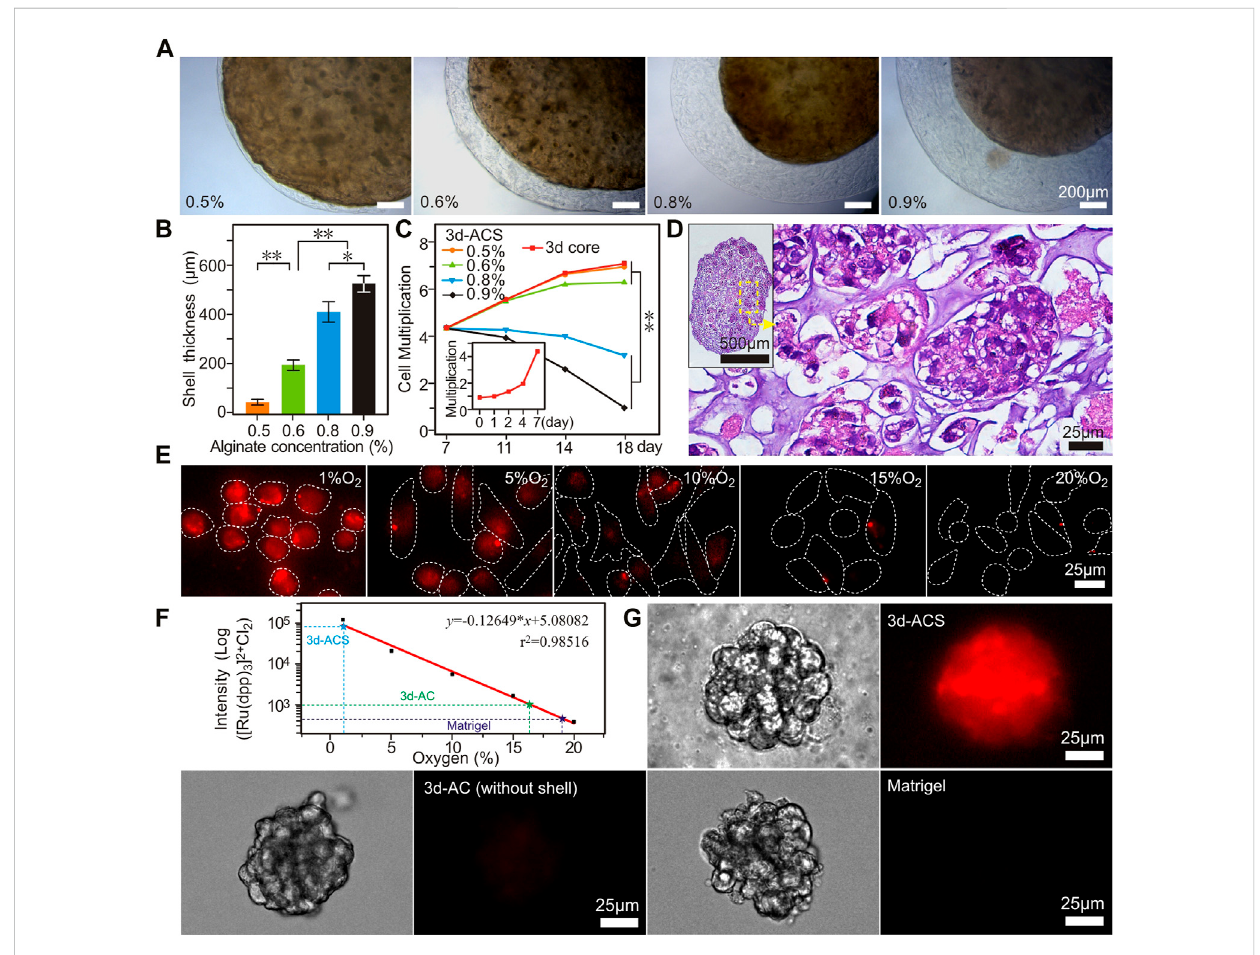
FIGURE 2 The core-shell structures (3d-ACS) with GC cells that constructed with 0.7% alginate (core) and 0.6% – 0.9% alginate (shell). (A) The shell structure is formed by polymerization with different alginate solutions. (B,C) Quanti fi ed thickness of the shell structures and cell proliferation in 3d-ACS (Inset C, cell proliferation in 1 – 7 days before shell structure formation). (D) H&E staining of the 3 d-ACS, the cancer cells grew in 3d-ACS and the organoid-like structure builtup gradually. (E) Fluorescenceof[Ru (dpp) 3 ] 2 + Cl2inGCcellscultured(2d)inhypoxia(1,5,10,15% O 2 ),normoxia(20% O 2 ). (F)